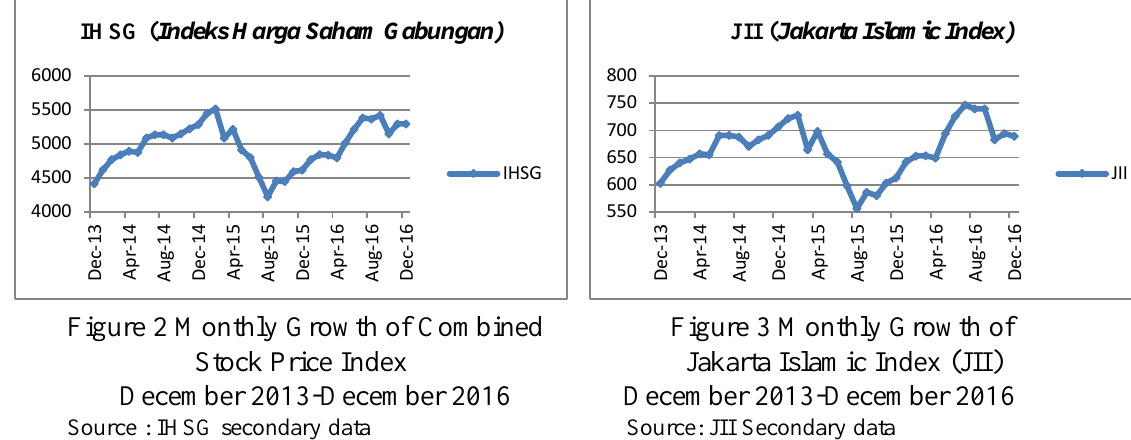
Figure 2 Monthly Growth of Combined Figure 3 Monthly Growth of Stock Price Index December 2013-December 2016 Source : IHSG secondary data Source: JII Secondary data